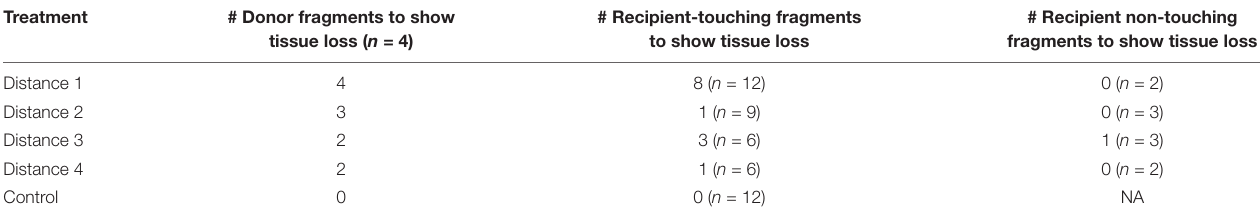
TABLE 5 | Experimental design for the M. cavernosa to M. cavernosa experiment with monitored lesion progression on donor and recipient fragments. Treatment # Donor fragments to show # Recipient-touching fragments # Recipient non-touching tissue loss ( n = 4) to show tissue loss fragments to show tissue loss